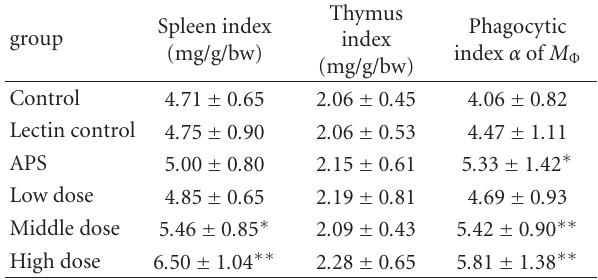
Table 3: E ff ects of concurrent application of APS and red kidney bean lectin on the spleen and thymus indices and phagocytosis of M Φ of mouse. Data represent means ± SD ( n = 10).